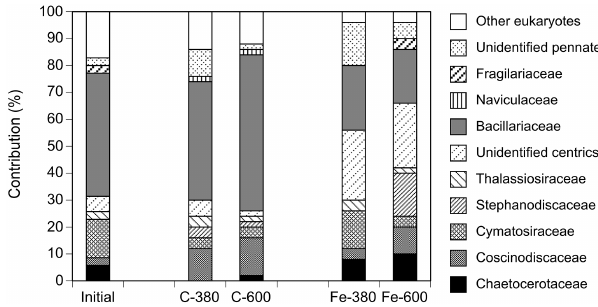
Figure 6. Relative phylotype contributions in the rbcL cDNA li- braries obtained from the initial seawater and the incubation bottles at day 2 (Fe-380 and Fe-600) and day 3 (C-380 and C-600).